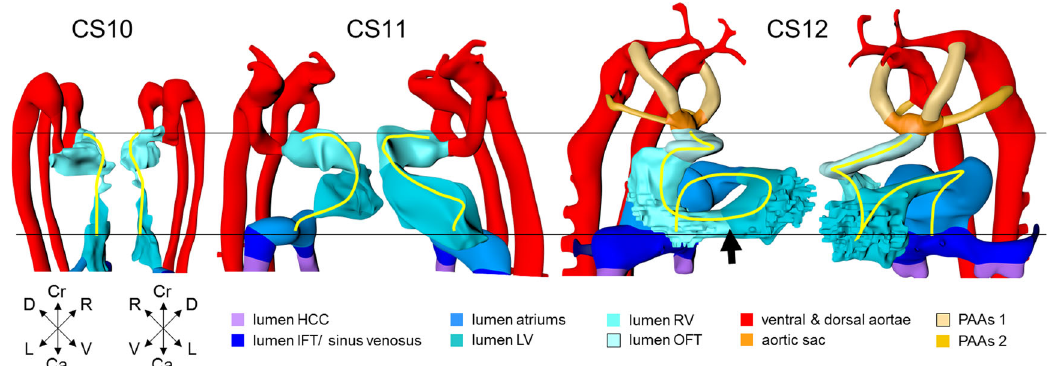
Fig. 2 Looping of the heart tube. The panels show ventral right and ventral left views of the cardiac lumen and the adjacent vessels in CS10-12 embryos. The panels were aligned on the arterial and venous poles of the heart loop (black horizontal line). The fi rst signs of looping are seen at CS10, when the dorsal mesocardium disappears at the junction of the embryonic ventricle and out fl ow tract. The center of the heart tube, represented by the yellow wire, bends rightward and ventrally, in particular in its cranial part. At CS11, the loop extends ventrally due to axial growth and becomes the more pronounced “ C ” loop. The embryonic left ventricle represents the most ventral portion of the heart loop at this stage. The atrioventricular junction has moved leftward, while the common atrium and distal part of the out fl ow tract remain midline structures. At CS12, endothelial sprouting into the cardiac jelly marks the boundaries of the ballooning apical parts of the ventricles (arrow). The heart loop between the left ventricle and distal out fl ow tract further increases in length in a rightward and dorsal direction, with the embryonic right ventricle emerging at its apex (see wire loop). Note that looping has induced two helical twists in the heart axis that meet in the right ventricle. All images are also available as preset views in the corresponding